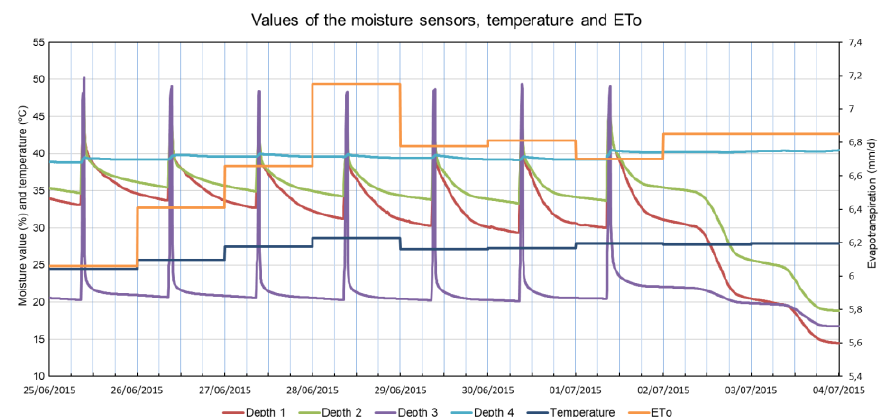
Figure 3. Sample values of the moisture sensors and agroclimatic data for a period of eight days from 26 June 2015 to 4 July 2015. The values of sensor 1 are shown in this plot. Depth 1: 10 cm; depth 2: 20 cm; depth 3: 30 cm; depth 4: 40 cm.